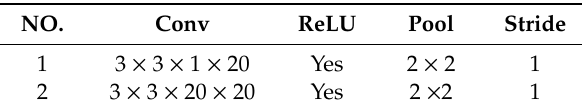
Table 1. Architecture of CNN.